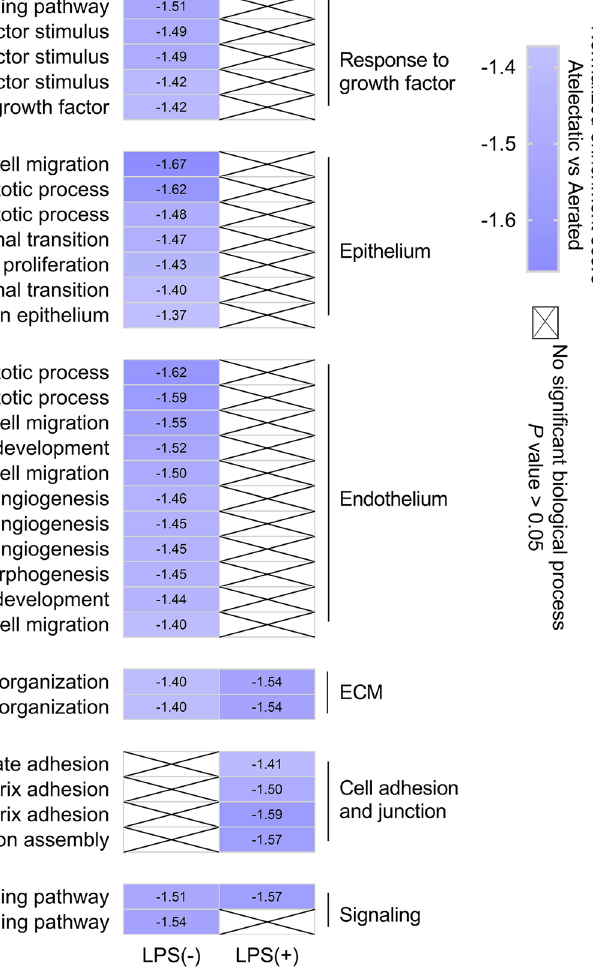
Figure 3. Processes and pathways related to alveolar-capillary barrier function in atelectasis. Functional analysis of proteomics data showed the negative enrichment for processes or pathways related to alveolar- capillary barrier function in LPS(−) and LPS(+) conditions. Without LPS, atelectasis was associated with negatively enriched epithelial and endothelial processes, as well as Hippo signaling pathway. With LPS, the negatively enriched processes in atelectasis were involved in cell adhesion and junction. ECM organization and TGF-β signaling were negatively enriched in LPS-exposed and unexposed atelectasis. LPS lipopolysaccharide, ECM extracellular matrix, TGF transforming growth